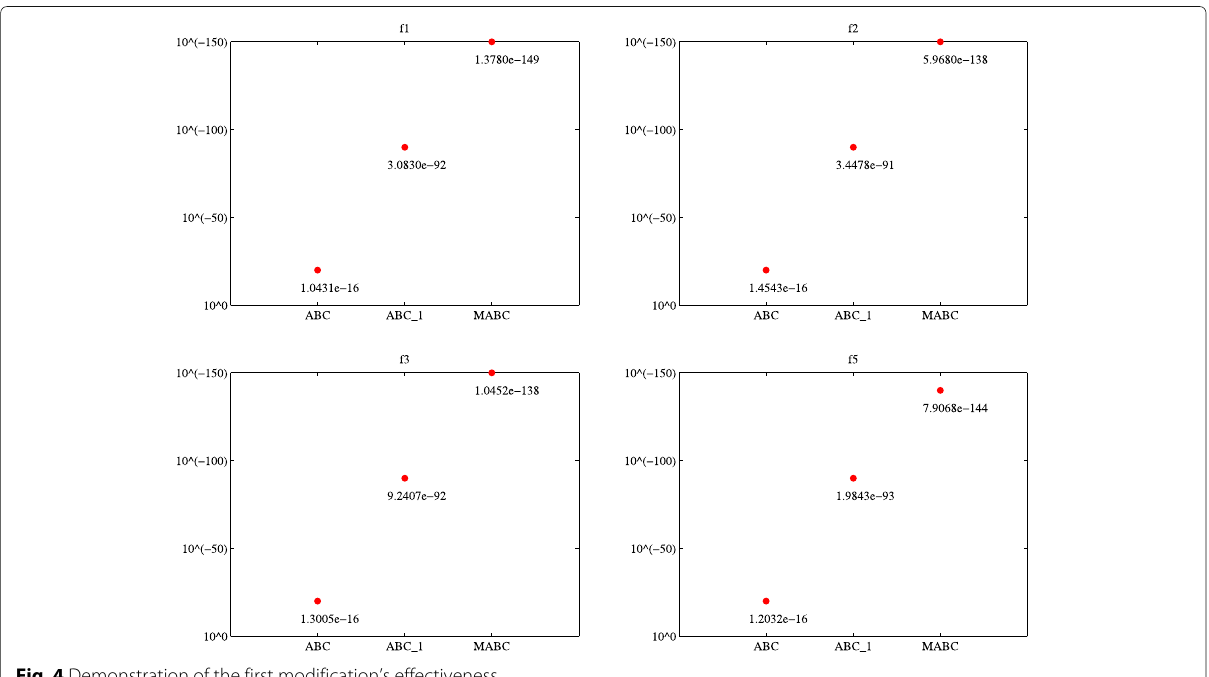
Fig. 4 Demonstration of the first modification’s effectiveness